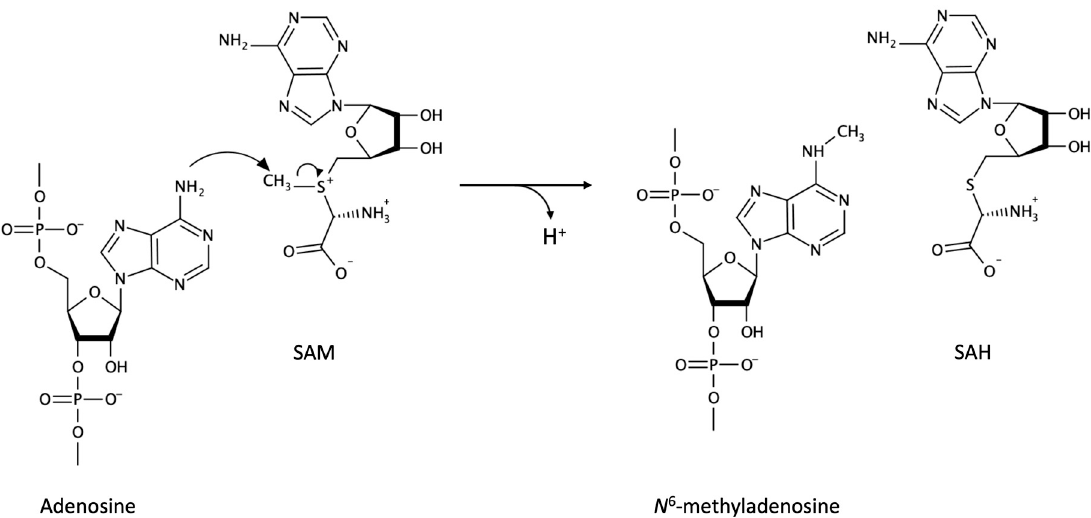
Figure 1. Molecular mechanism of N 6 -methyladenosine methylation. SAM: S-adenosylmethionine. SAH: S-adenosyl-L-homocysteine.